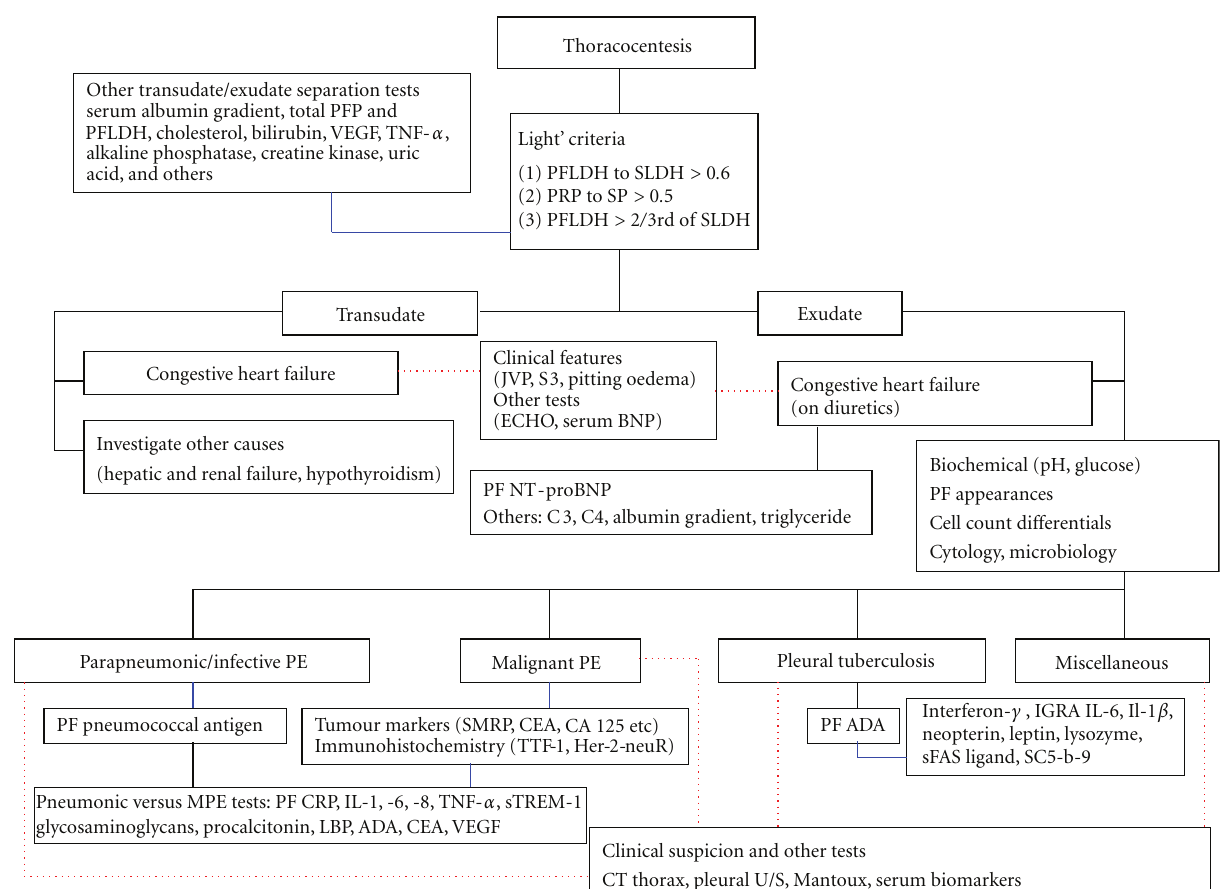
Figure 1: Recommended algorithm for investigation of pleural e ff usion. The use of Light’s criteria is recommended when a thoracocentesis revealed a protein level between 25 and 35g/L to narrow down the di ff erential diagnosis by determining whether a pleural e ff usion is transudative or exudative. NT-proBNP should be measured when a suspected cardiac e ff usion meets the exudative criteria. Determining causes of an exudative e ff usion is more challenging, and routine test, including biochemical measurement (i.e., pH and glucose), di ff erential cell counts, cytology, and routine microbiology test are diagnostically useful. Pleural fluid pneumococcal antigen has been shown to be superior than urinary antigen to identify bacterial-induced pleural e ff usion. Tumour marker such as SMRP has a good diagnostic value to diagnose mesothelioma, however, the diagnostic utility of other tumour markers remains limited. Immunocytochemical evaluation of pleural fluid specimen is helpful in labelling di ff erent tumour markers. Other biological markers to di ff erentiate parapneumonic/infective and malignant e ff usion remain elusive, expensive, and not widely available. Testing of pleural fluid ADA is an inexpensive and e ffi cacious method for diagnosing tuberculous e ff usion, regardless of the patient’s immune status. Other tuberculosis-related inflammatory markers are available but are not superior to the latter. (PF: pleural fluid, black continuous line: strongly recommended and routinely practised, blue continuous line: not strongly recommended and not routinely practised, red dotted line: complementary diagnosis with other nonpleural